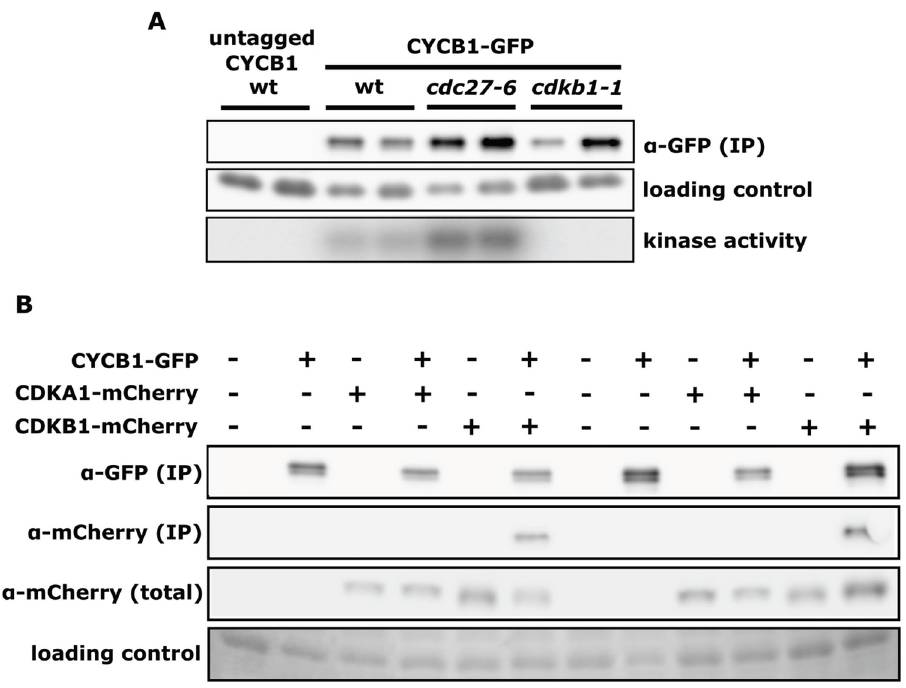
Fig 1. Detection of CYCB1-GFP binding partners and kinase activity by co-immunoprecipitation. (A) Top row: anti-GFP immunoblotting of CYCB1-GFP pull-down in untagged control (‘wt’), wt, cdc27-6 , or cdkb1-1 backgrounds. CYCB1-GFP was pulled down from lysates of cells that were first synchronized by nitrogen deprivation, then moved to restrictive temperature (33˚C) in complete medium and collected after 13 hours. Typically, after 13 hrs. at 33˚C, wild- type cells have undergone multiple fissions, and CYCB1-GFP level from a large population of cells is high (see, for example, the time course in S1 Fig, and microscopic images of wild-type in S5A Fig). Middle row: loading control is non-specific anti-GFP signal from immunoblot of total lysates before they were used for IP shown in the top row. Bottom row: kinase activity from immunoprecipitates shown in top row. All strains except for untagged wt control on left had temperature-sensitive cycb1-5 rescued by CYCB1 : GFP-TG transgene. Equal biomass based on OD 750 was extracted and immunoprecipitated from each sample. Two independent strains were tested for each genotype. (B) Detection of CDKA1-mCherry or CDKB1-mCherry as possible binding partners of CYCB1-GFP. Strains with the indicated combinations of CYCB1-GFP and CDKA1-mCherry or CDKB1-mCherry were immunoprecipitated with anti-GFP from lysates of cells that were first synchronized by nitrogen deprivation, then moved to restrictive temperature (33˚C) in complete medium and collected after 13 hours, a time when cells are mid-division phase based on prior experiments with this protocol. Input biomass was equalized by OD 750 . Immunoblotting was then done with anti-GFP or anti-mCherry. Two independent strains were tested for each genotype, such that lanes 7–12 reproduce the experiment in lanes 1–6. Loading control (bottom row) is non-specific protein staining from total lysates before immunoprecipitation.